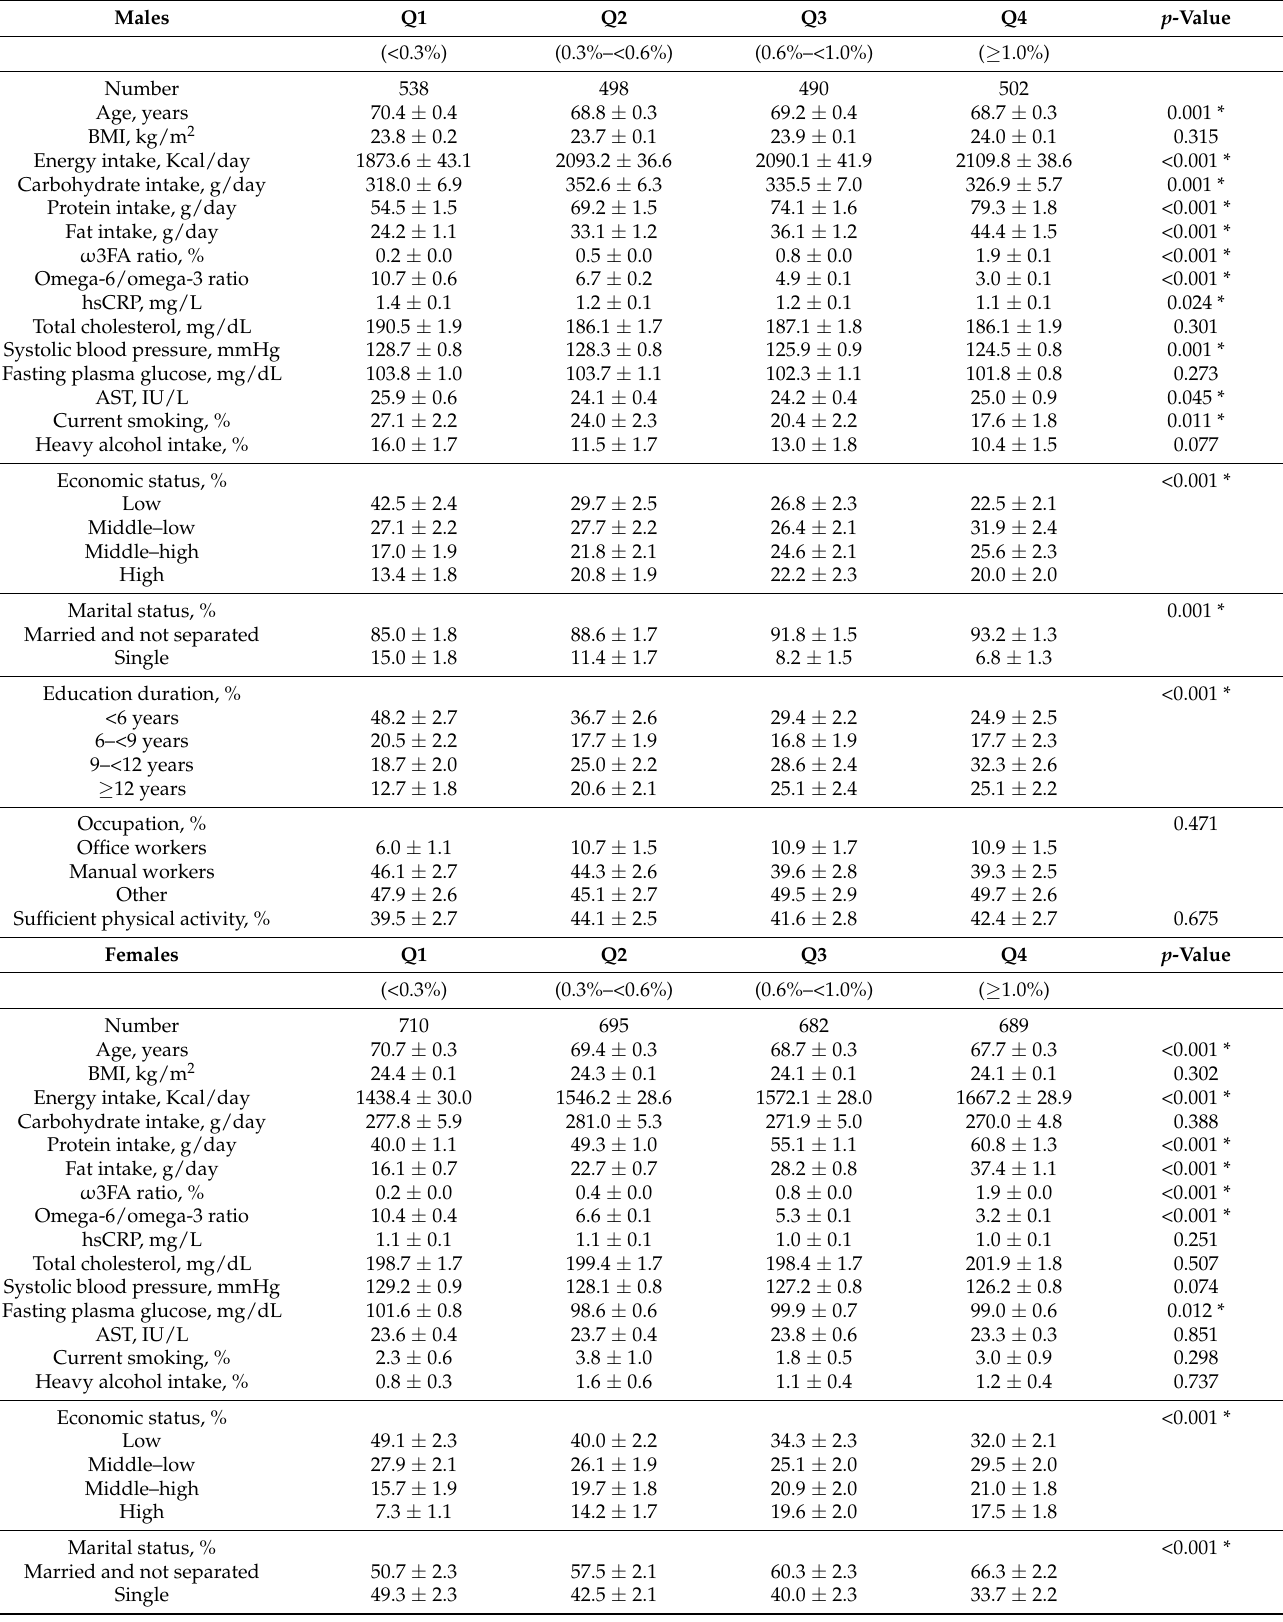
Table 2. Population characteristics according to quartile of ω 3FA